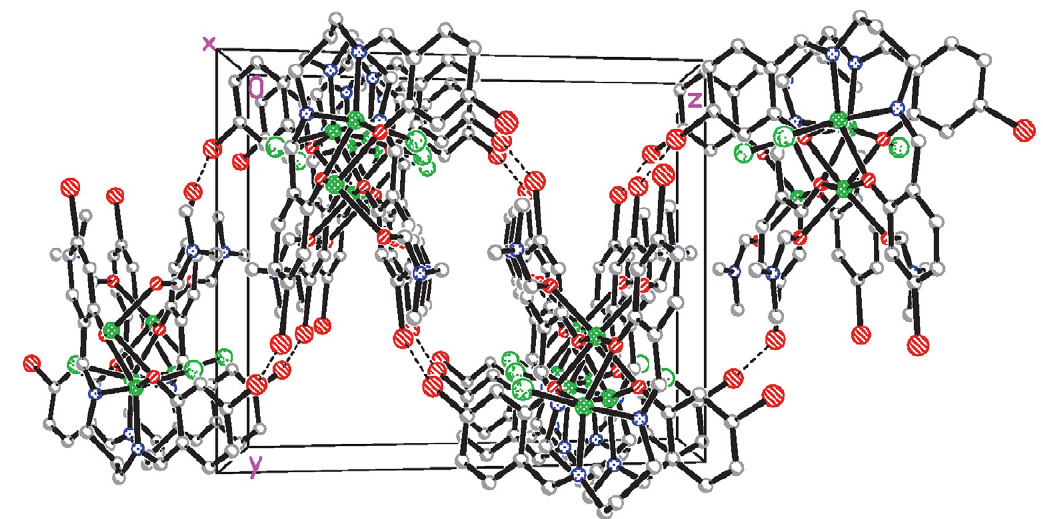
Fig. 4. Packing structure for complex 2 viewed along the x axis. Dashed lines represent Br···Br interactions forming zigzag chains along the z axis.